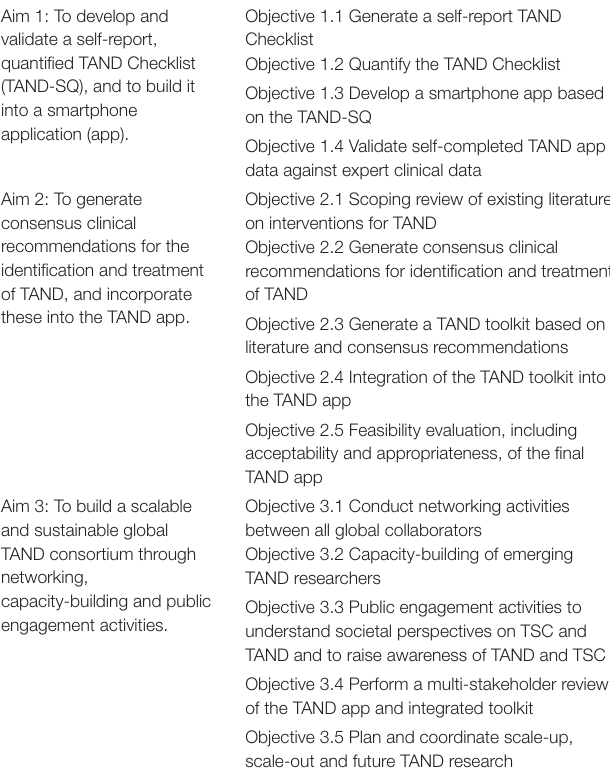
TABLE 1 | TANDem project aims and objectives. Aim 1: To develop and validate a self-report, quantified TAND Checklist (TAND-SQ), and to build it into a smartphone application